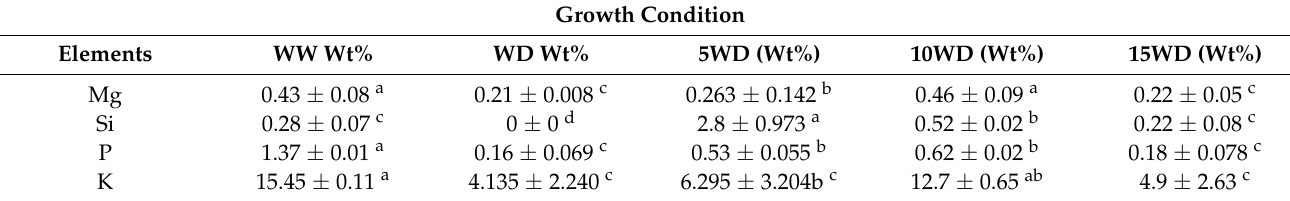
Table 2. Overall weight percentage (W%) of element distribution in sorghum plants under drought stress primed with and without α Fe 2 O 3 NPs. WW = well-watered (control); and WD = water-deprived (drought stress); 5 WD = water-deprived + 5 mg/L α Fe 2 O 3 NPs; 10 WD = water-deprived + 10 mg/L α Fe α Fe 2 O 3 NPs; 15 WD = water-deprived + 15 mg/L 2 O 3 NPs. Data in the table represent the mean ± standard deviation ( n = 3). Different letters indicate significant differences ( p < 0.05) based on one-way ANOVA using the Tukey’s comparison